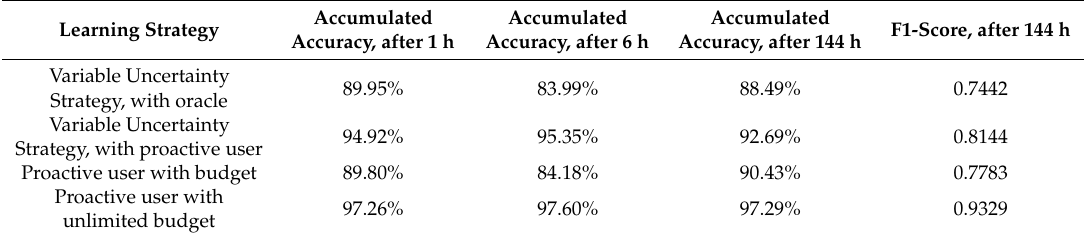
Figure 5. The accumulated accuracy for Variable Uncertainty Strategy with and without proactive user vs. Proactive User with and without budget limit. Table 3. The accumulated accuracy and F1-score for user strategies in dynamic